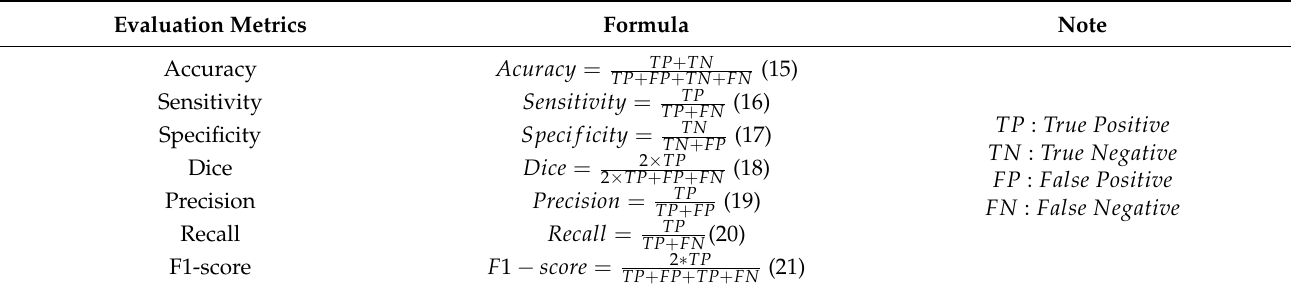
Table 2. Formulas for each evaluation metric.